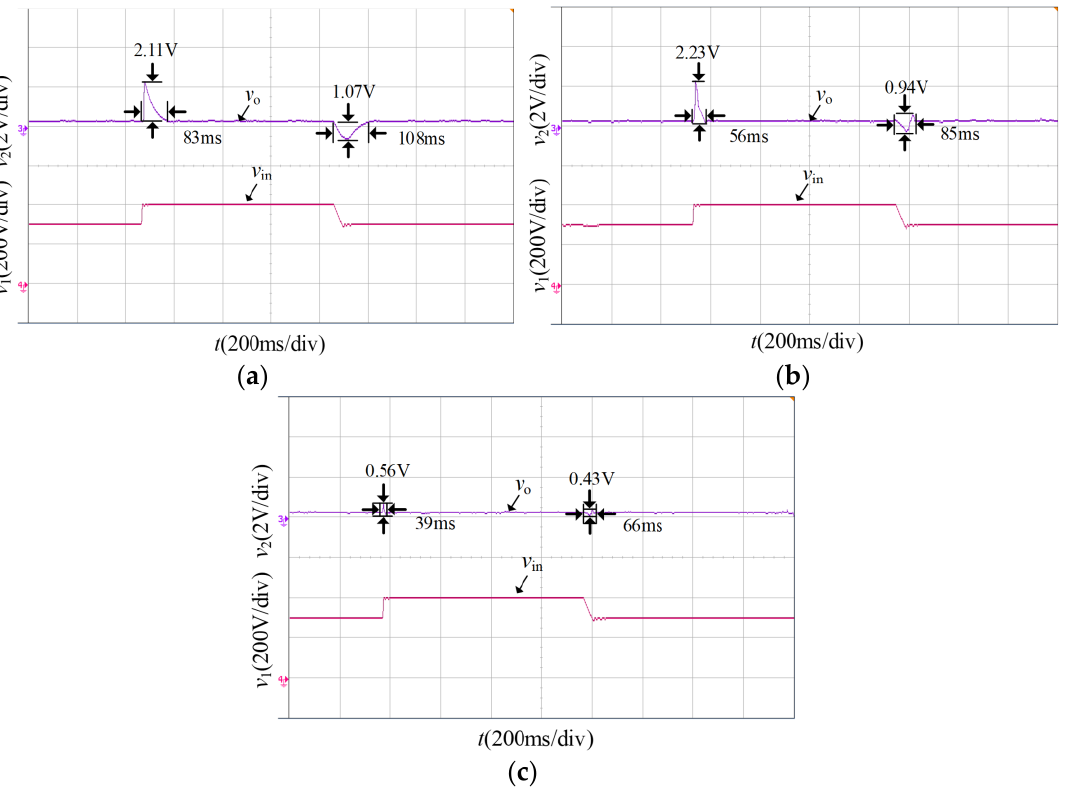
Figure 21. The dynamic response during v 1 step in step-down mode (300 – 400 V): ( a ) PBC; ( b ) PBC with PI; ( c ) PBC with LADRC. Table 5. The dynamic performance comparison during the v 2 step in step-down mode. PBC PBC with PI Input volt-